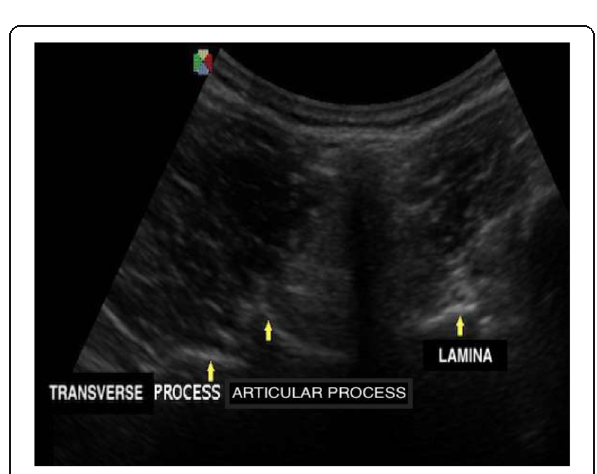
Fig. 7 The transverse axial sonogram of lumbar vertebra shows the spinous process, lamina, articular process, and transverse process